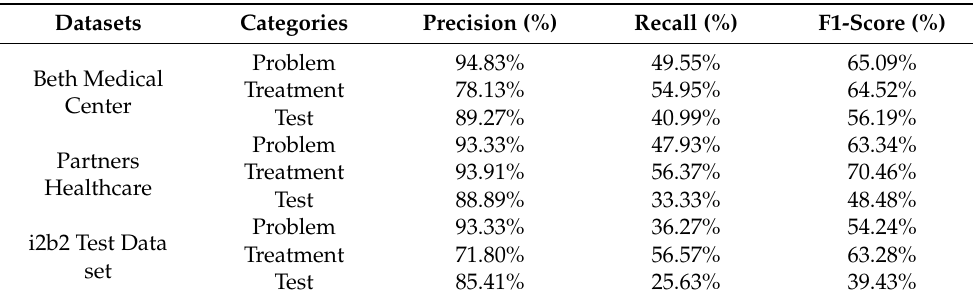
Table A1. Individual concepts’ performance measures for the Beth, Partner, and Test datasets, employing exact term matching to UMLS.